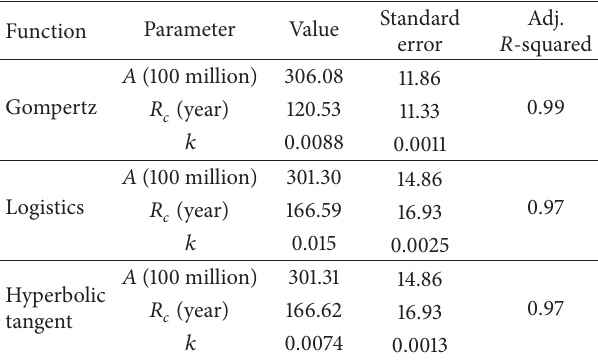
Table 3: Function fitting results in 1999.